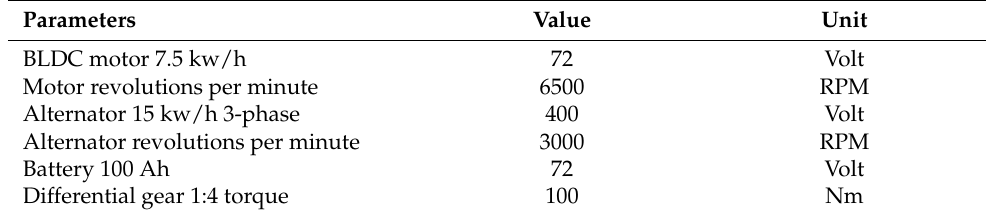
Table 3. Technology for interfacing with cyclic power generation circuits in the